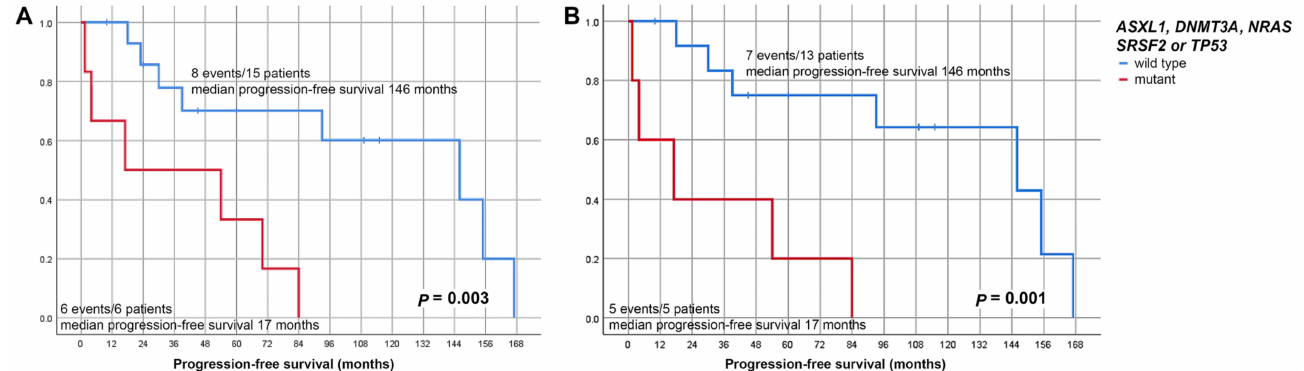
Figure 3. Progression-free survival of all MPN and MDS/MPN cases ( A ) and MPN cases only ( B ), bearing mutations in either AXSXL1 , DNMT3A , NRAS , SRSF2 or TP53 compared to that of cases that did either not progress (these cases did not bear such mutations) or progressed but did not display such